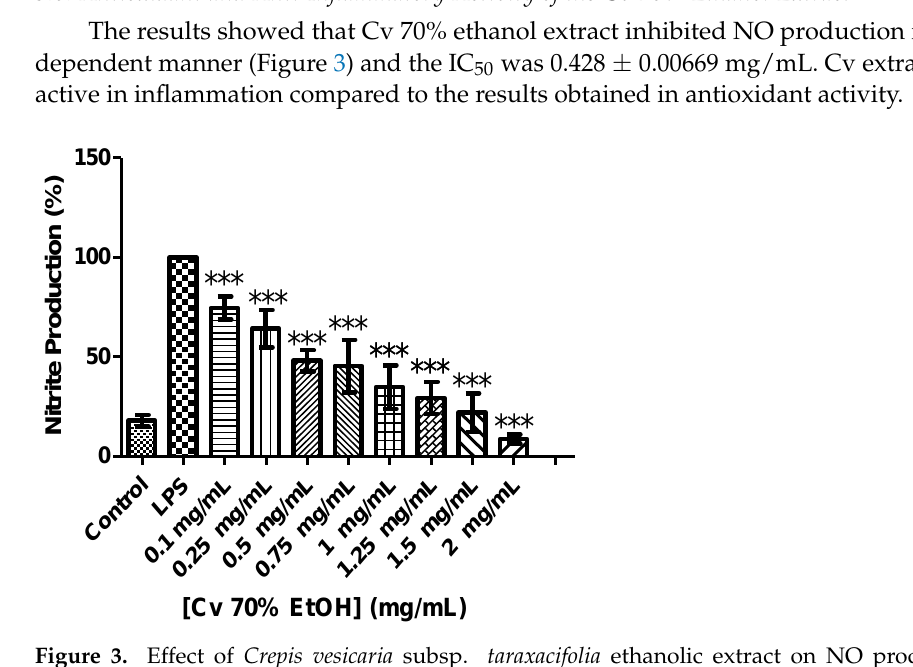
Figure 2. Effect of Crepis vesicaria subsp. taraxacifolia ethanolic extract on macrophages cell viability (RAW 264.7 cells). Each result represents the mean ± SD (minimum of three independent assays, performed in duplicate). The statistical tests were performed with p < 0.05 compared to control.